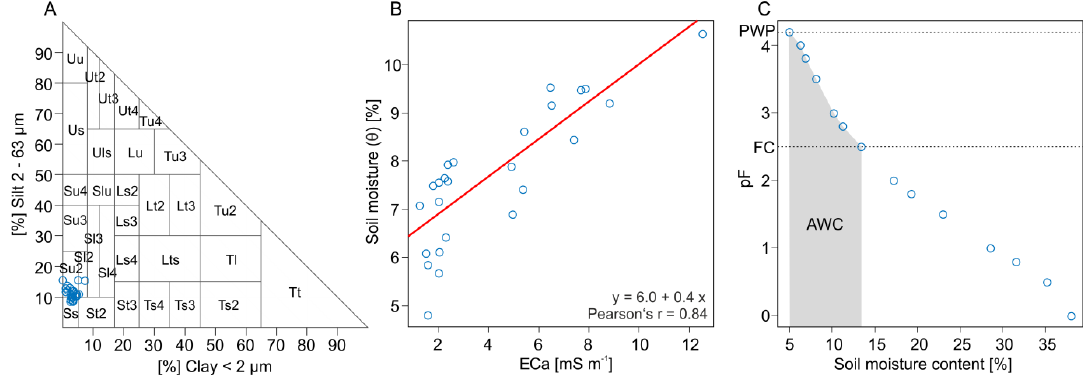
Figure 9. ( A ) Soil texture classes of the 25 lab-analysed reference soil samples. ( B ) Linear regression analysis of apparent electrical conductivity (deep) and soil moisture. ( C ) Mean water retention curve of Königsfeld based on soil texture of the samples and the soil physical data base of [37]. (PWP: Permanent wilting point, FC: Field capacity, AWC: Available water content).